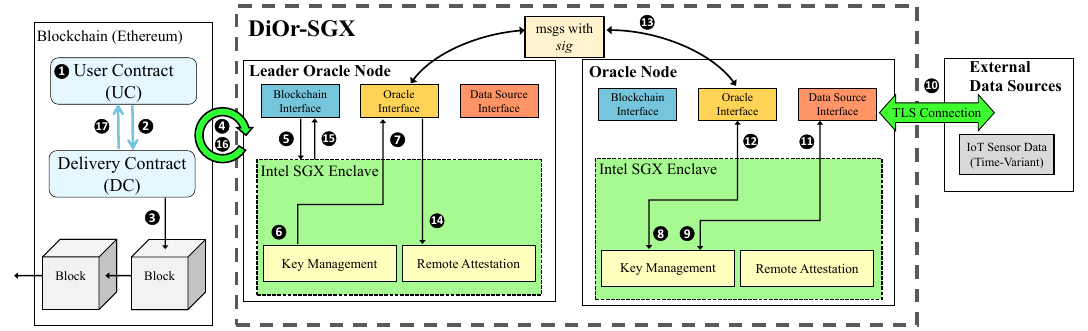
Figure 5. Delivery Process of Oracle Request and External